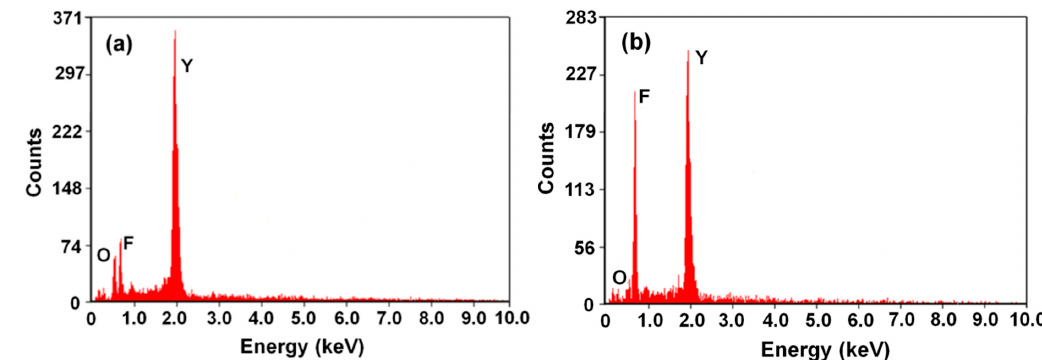
Figure 3. Energy dispersive X-ray diffraction (EDX) results of ( a ) YOF and ( b ) YF 3 coated under a plasma spray power of 15 kW. Table 2. Compositions of YOF and YF 3 obtained by energy dispersive X-ray diffraction (EDX).